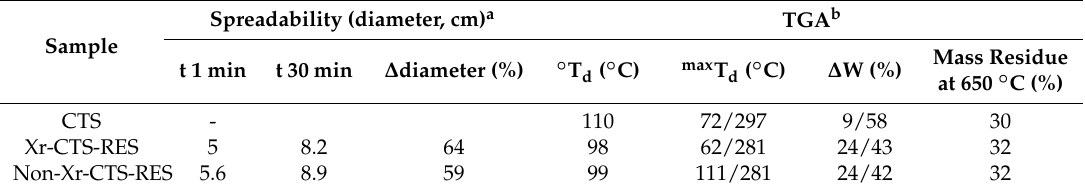
Table 4. Comparison of spreadability and TGA (Thermogravimetric Analysis) data of resveratrol- loaded hydrogel-NP composites (with cross-linked NP and non-cross-linked NP.